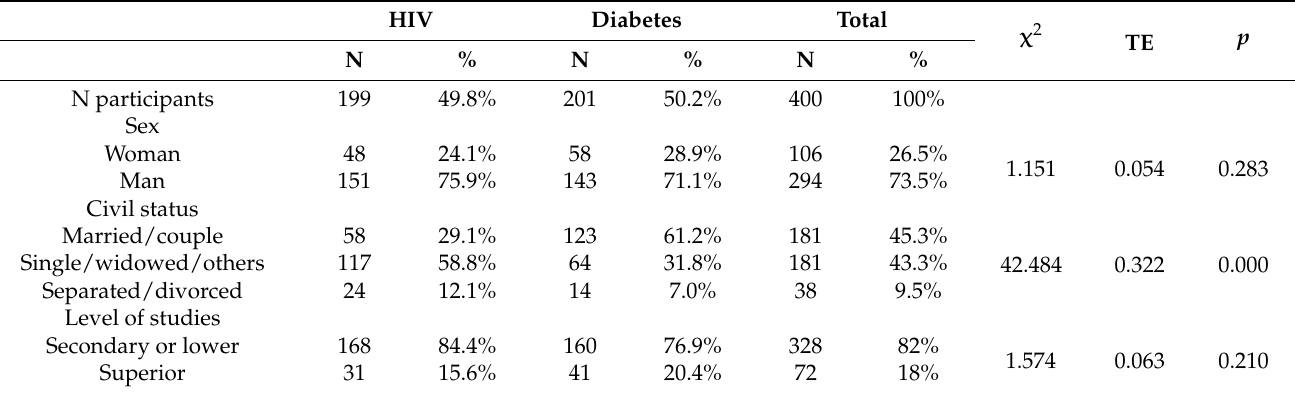
Table 1. Sociodemographic variables based on health